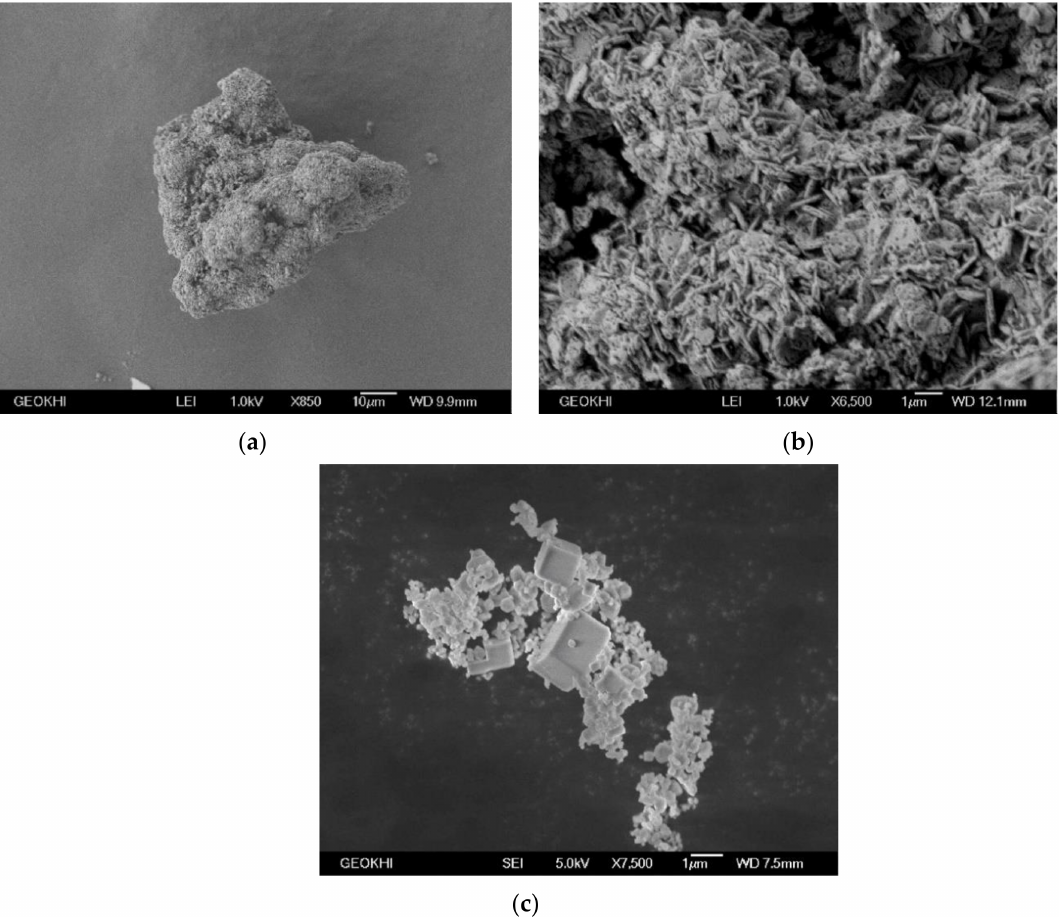
Figure 3. Scanning electron microscope (SEM) images of MgO ( a , b ) and calcined MgO ( c